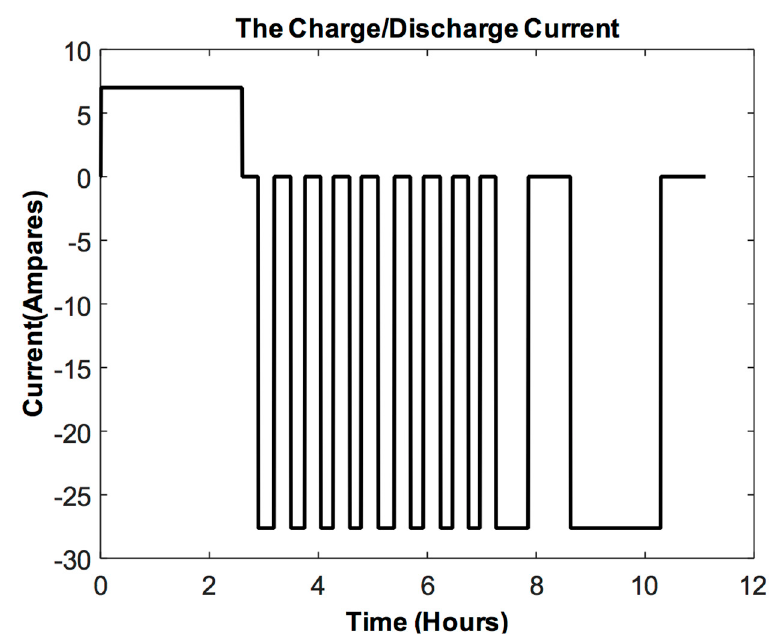
Figure 8. The battery pack charge/discharge current. Energies 2020 , 13 , 5600